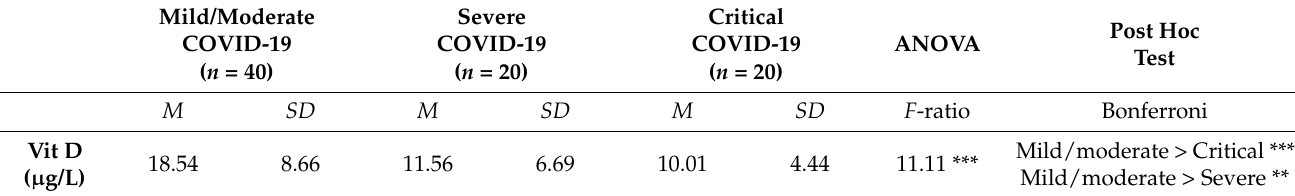
Table 7. Correlation of 1,25 dihydroxy vitamin D with severity of the disease.